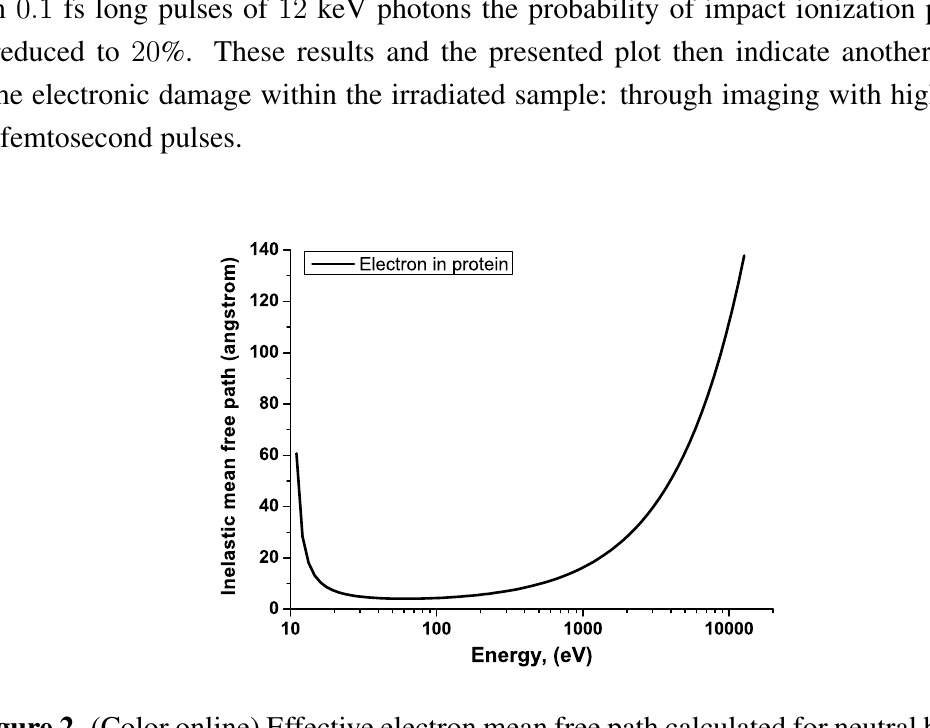
Figure 2. (Color online) Effective electron mean free path calculated for neutral bulk protein of density 1 . 35 g/cm 3 consisting of hydrogen atoms (50%) , carbon atoms (30%), oxygen atoms (10%), nitrogen atoms (9%) and sulphur atoms